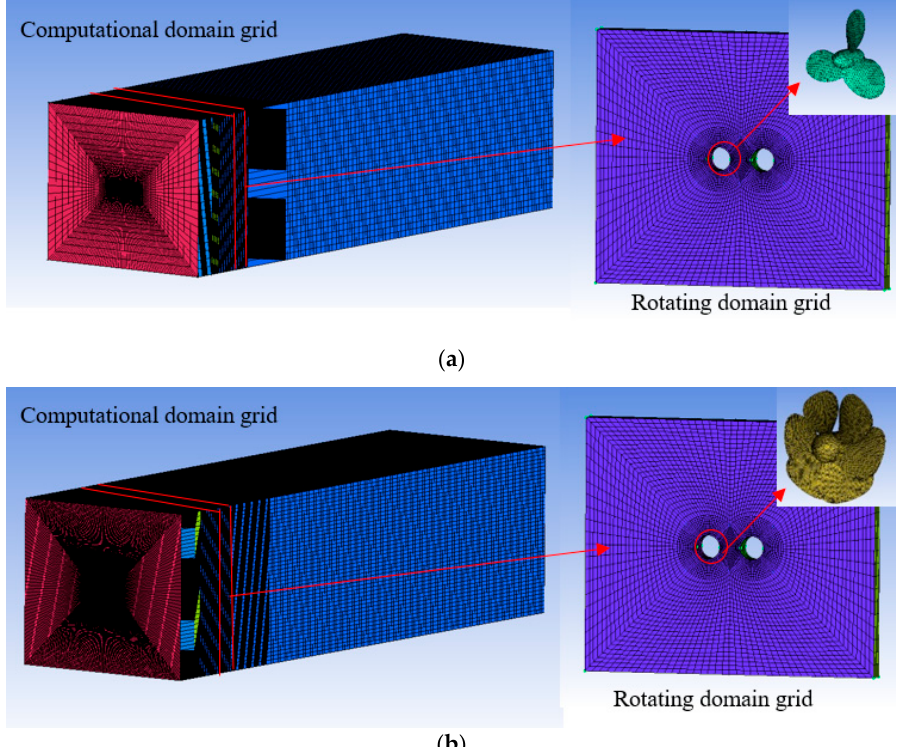
Figure 2. Meshed twin-propeller system: ( a ) Water subdomain of Twin-propeller-76; ( b ) Water subdomain of Twin-propeller-131. Arrow shows the zoom-in on a particular